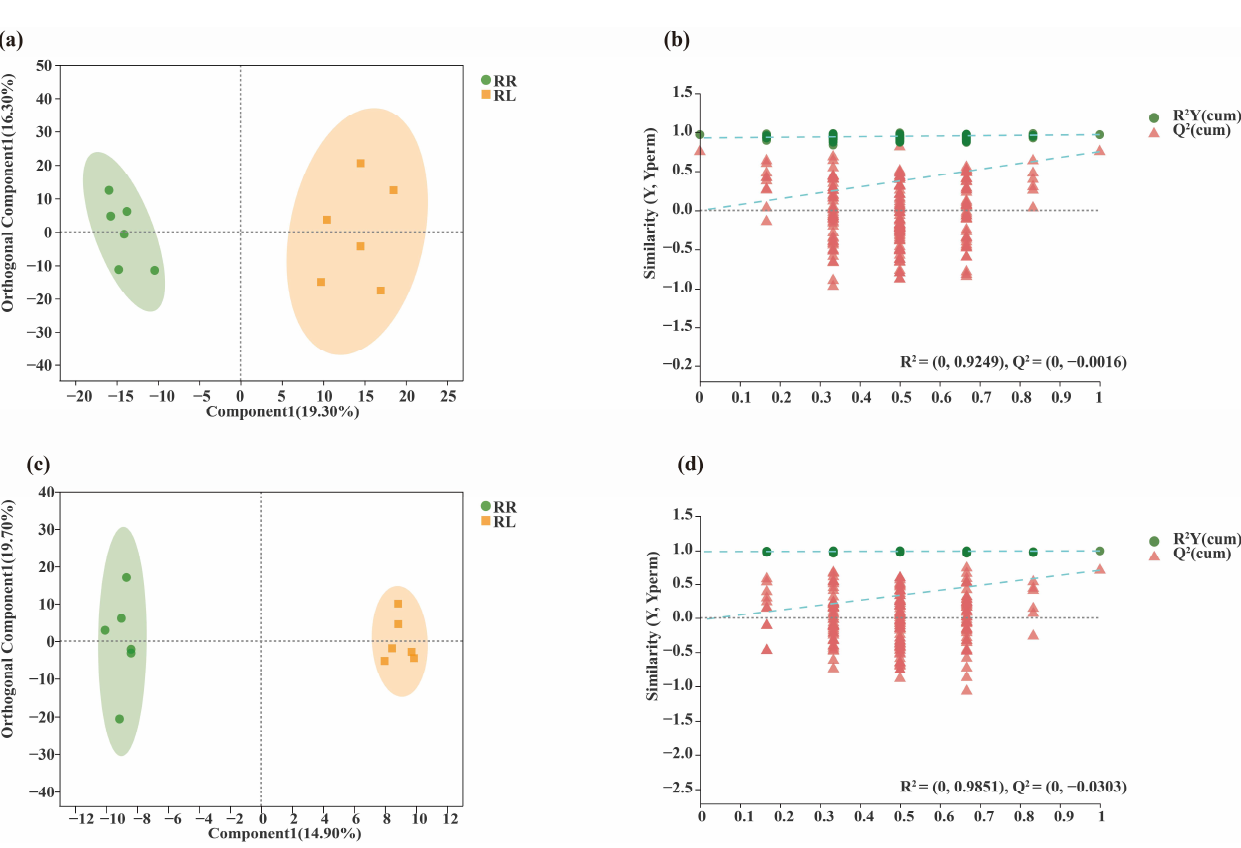
Figure 9. Orthogonal partial least squares discriminant analysis (OPLS-DA) plot of RR and RL metabolites when comparing the RR and RL groups following ( a ) positive mode ionization; ( b ) permutation test of OPLS-DA in positive mode ionization; ( c ) negative mode ionization; ( d ) permutation test of OPLS-DA in negative mode ionization. Table 5. The metabolites of differential root exudates in rhizospheres of oilseed rapes between RR and RL